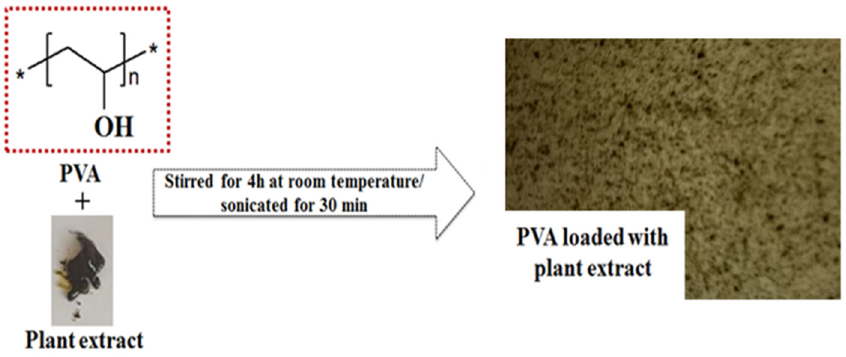
Figure 1. Schematic representation of PVA film loaded with plant